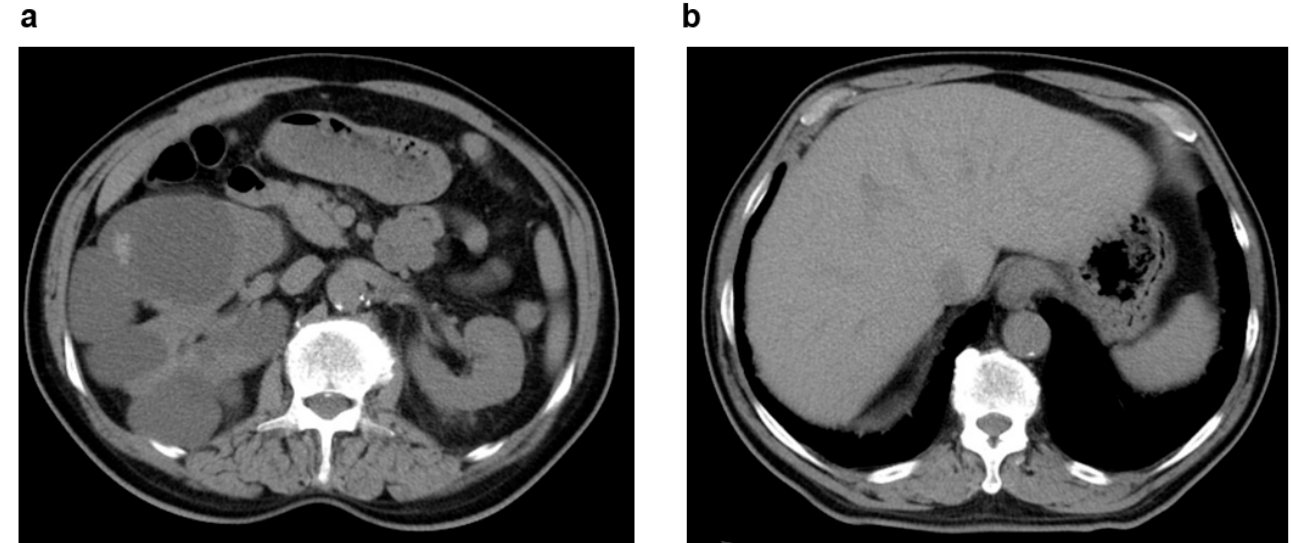
Figure 5. Unilateral renal cystic disease: 70s, male, no family history of polycystic kidney disease or end-stage kidney disease, no hepatic cysts, cerebral aneurysm, or history of heart valve disease, kidney function eGFR 82.7 mL/min/1.73 m 2 (image provide by Kurume University). ( a ) Non-contrast CT image (horizontal section): the right kidney shows multiple variously sized cysts, while bilateral renal volume is 1401 mL. ( b ) Non-contrast CT image (horizontal section): no hepatic cysts.